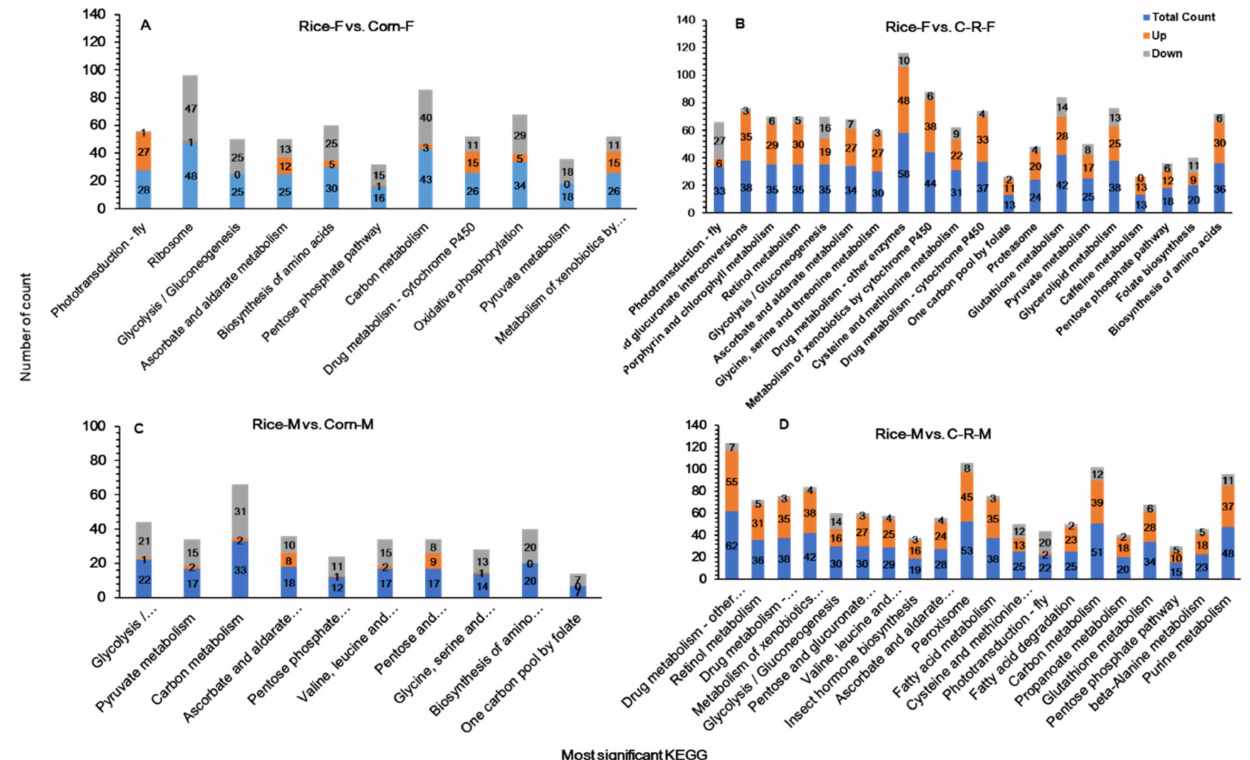
Figure 11. Enriched KEGG pathways for up and down regulated DEGs and the ratio of the DEG number to the total gene number in a certain pathway for Female (F) and Male (M) antennae in the Rice-F vs. Corn-F ( A ), Rice-F vs. C-R-F ( B ), (After 20 generation of selection the corn population was fed on rice for one generation (C-R-female) Rice-M vs. Corn-M ( C ) and Rice-M vs. C-R-M antennae ( D ) After 20 generation of selection the corn population was fed on rice for one generation (C-R-male) of Spodoptera frugiperda when reared on corn and rice plants for 20